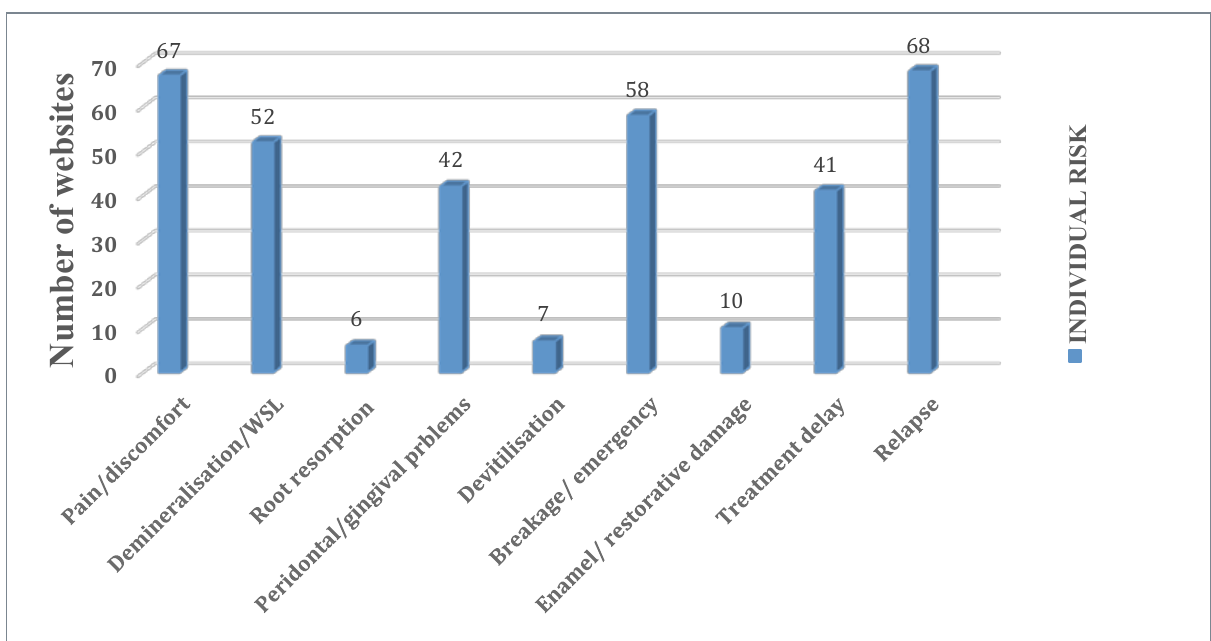
Table III. Number of websites reporting individual risks (N = 105).